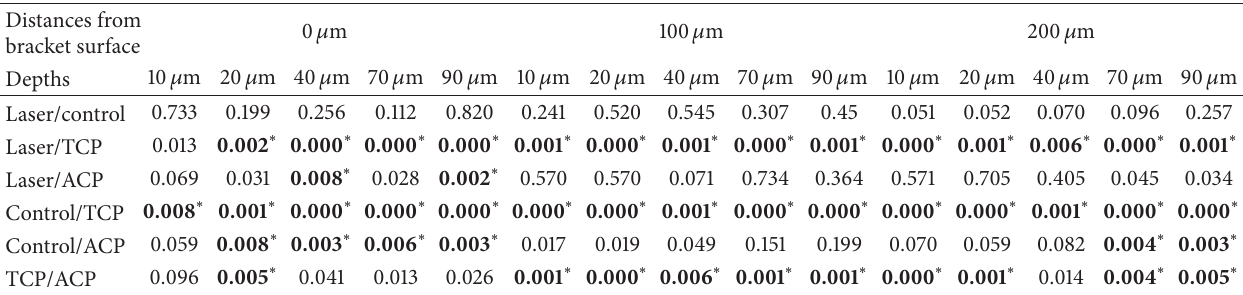
Table 2: Post hoc statistical comparisons of microhardness values of specimens from 3 positions and 5 depths from the coronal side of bracket surface. Distances from 0 𝜇 bracket surface